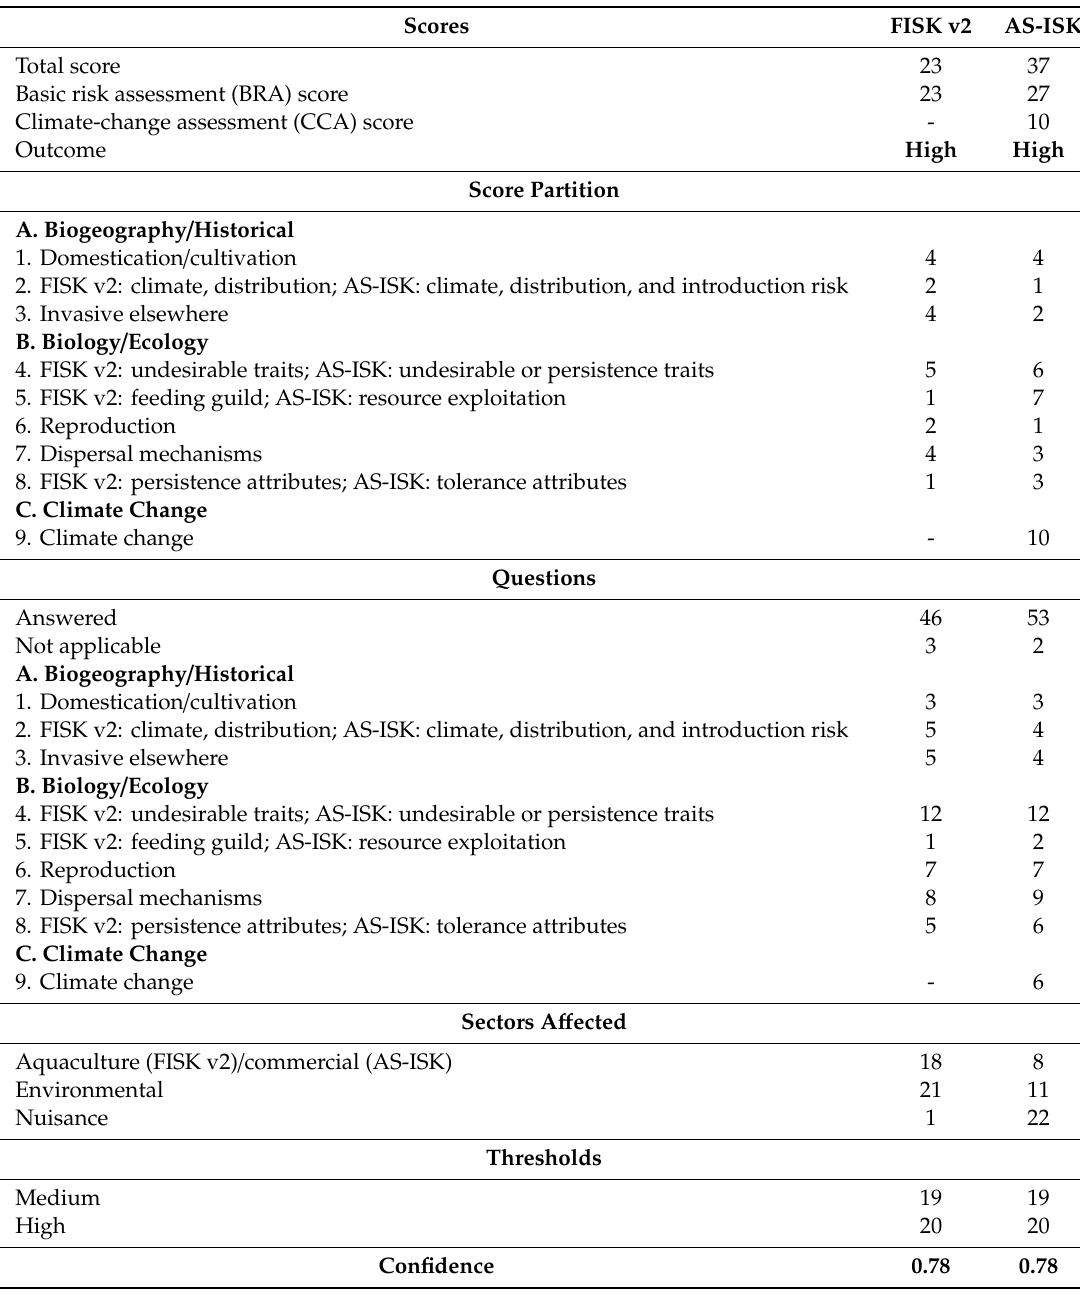
Table 2. Statistical summary of Fish Invasiveness Scoring Kit (FISK) v2 and Aquatic Species Invasiveness Screening Kit (AS-ISK) scoring for A. facetus in